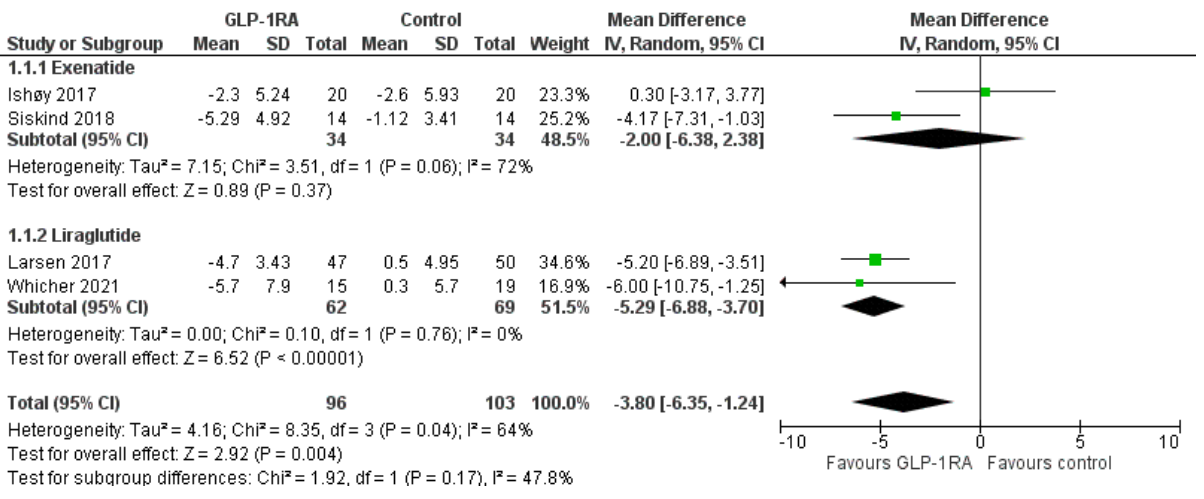
Figure 2. Effect of GLP-1RAs compared to controls on body weight among individuals treated with antipsychotic drugs. The diamond represents the overall effect estimate of the meta-analysis. The findings of each study are plotted as one square.